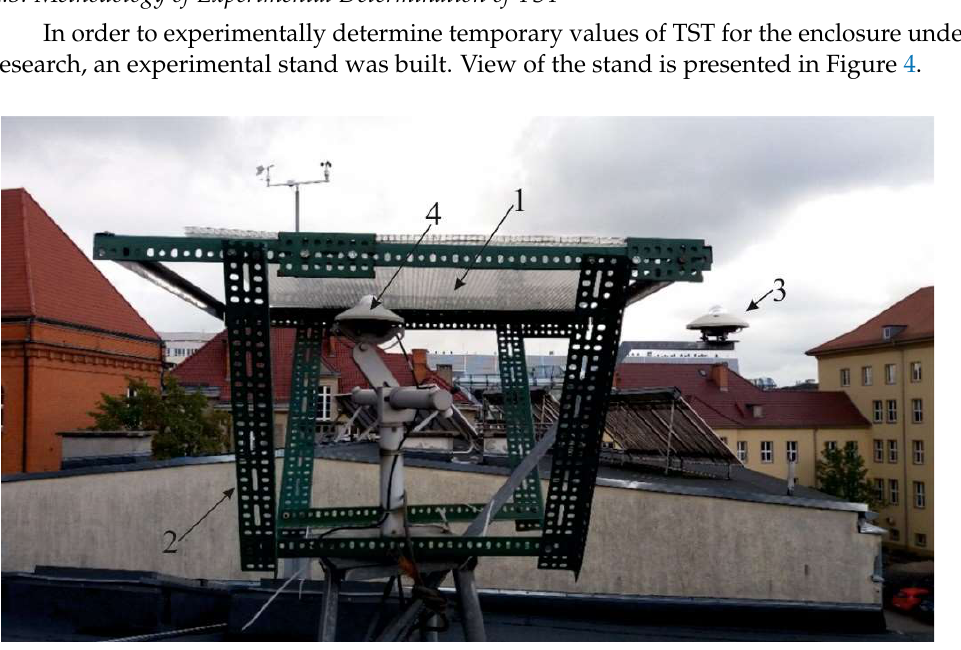
Figure 4. View of experimental stand (photo: Z. Zapałowicz): 1. Polycarbonate sheet; 2. Stand; 3. 195 Pyranometer located above sheet; 4. Pyranometer located under sheet. 3. Pyranometer located above sheet; 4. Pyranometer located under